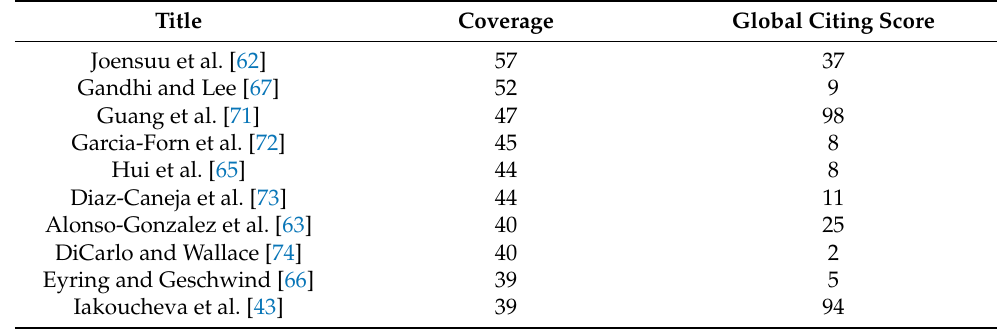
Table 3. Top 10 citing papers in Cluster #0 identified using DCA.